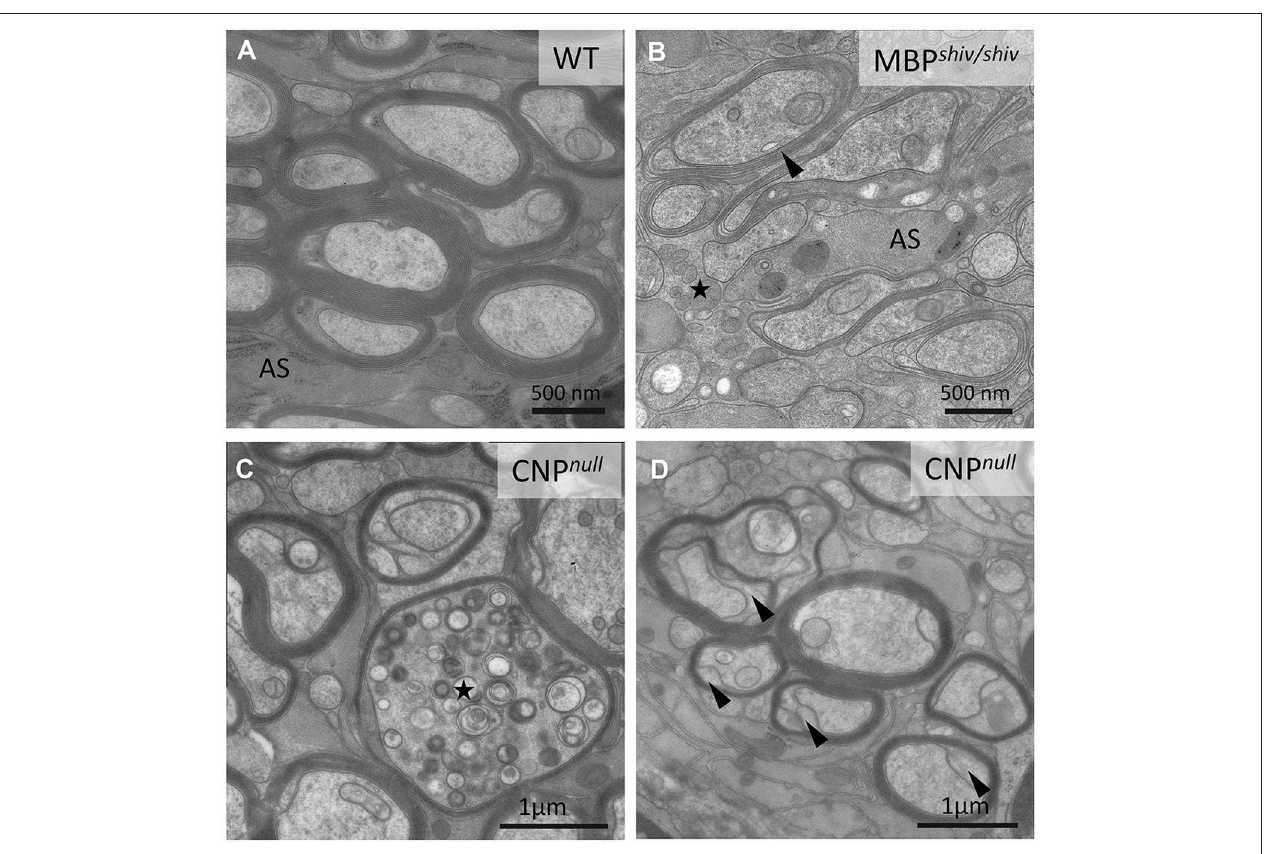
FIGURE 4 | Morphological characteristics of white matter in mouse “myelin mutants”. (A) Normal myelinated optic nerve axons. (B) In the shiverer mouse, oligodendrocytes lacking myelin basic protein (MBP) are not able to form compact myelin, though a few loose myelin-like wraps are observed. Note the increased oligodendrocytic processes (asterisk). AS: Astrocyte process. (C,D) In contrast, the CNP null mouse produces compact myelin but develops pronounced axonal swellings (asterisks in C ) and enlarged inner tongues (arrowheads in D